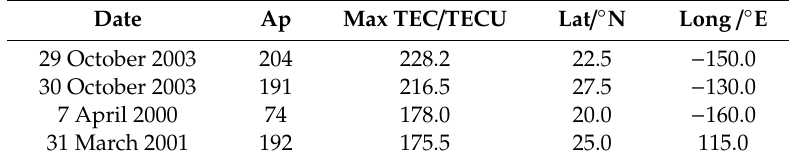
Table 1. Preselected dates and locations showing maximum total electron count (TEC) in TEC Units (TECU). Table1. Preselecteddatesandlocationsshowingmaximumtotalelectroncount(TEC)inTECUnits(TECU).